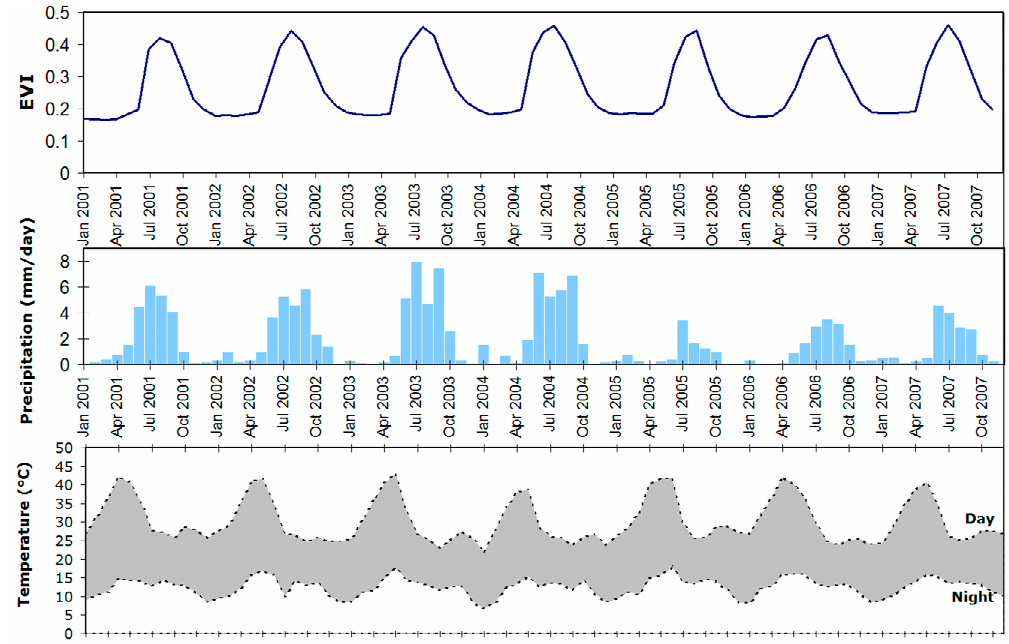
Figure 2. Average Monthly Enhanced Vegetation Index (EVI), Precipitation, and Temperature, 2001–2007, for entire the Lerma-Chapala-Santiago